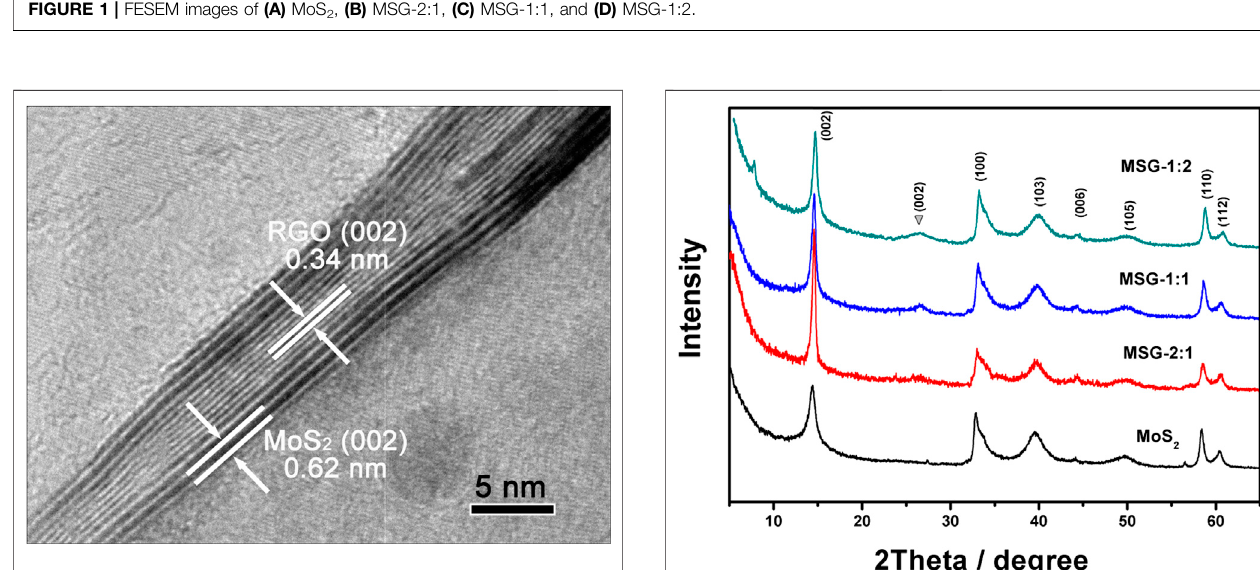
FIGURE 1 | FESEM images of (A) MoS 2 , (B) MSG-2:1, (C) MSG-1:1, and (D) MSG-1:2.